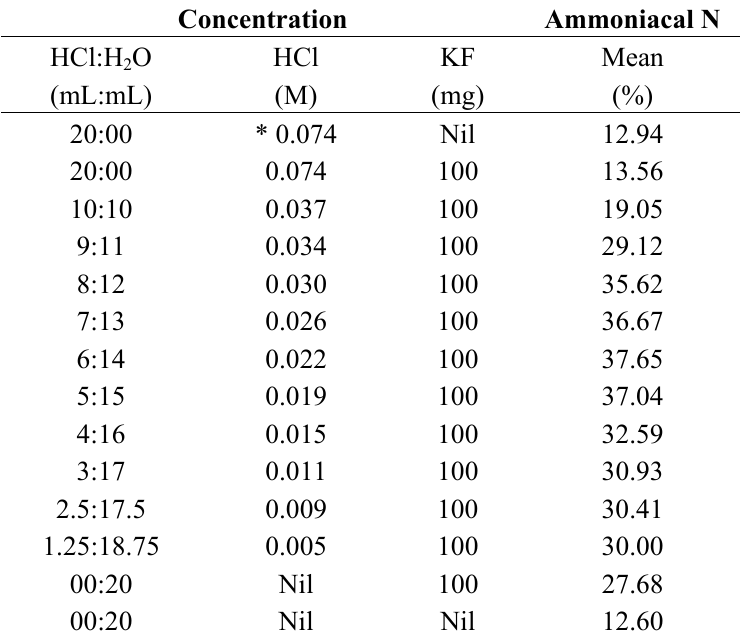
Table 1. Effect of acid dilution on protein hydrolysis activity of kiwifruit protease (100 mg KF) on 600 mg of FDM (freeze dried meat) measured by the percentage of ammoniacal nitrogen in the supernatant of the hydrolysates after 60 min incubation at 37 °C. Concentration Ammoniacal